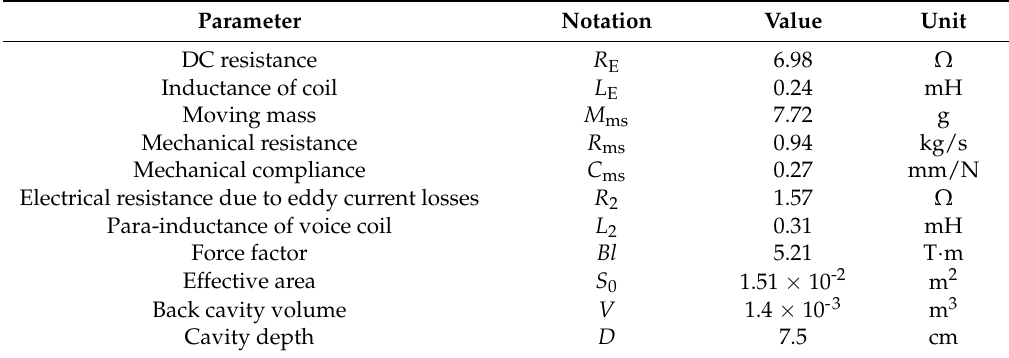
Table 5. Measured TS parameters and dimensions of a closed-box loudspeaker (SL 3